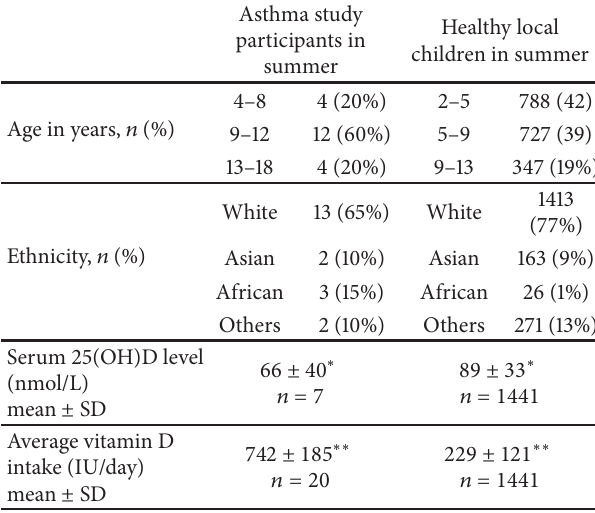
Table 2: Comparison of the study participants and healthy children in the same city and